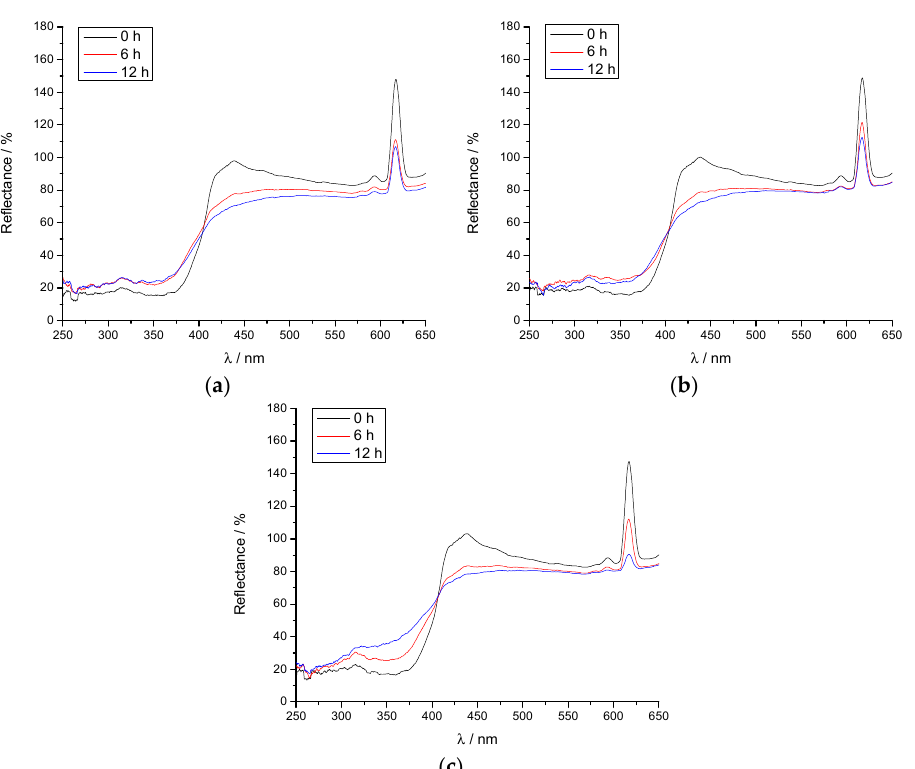
Coatings 2021 , 11 , x FOR PEER REVIEW Figure 5. Spectral reflectance of unaged and aged coatings: ( a ) FC + 1% SiO 2 ; ( b ) FC + 2% SiO 2 ; ( c ) FC + 3% SiO 2 . Figure 5. Spectral reflectance of unaged and aged coatings: ( a ) FC + 1% SiO